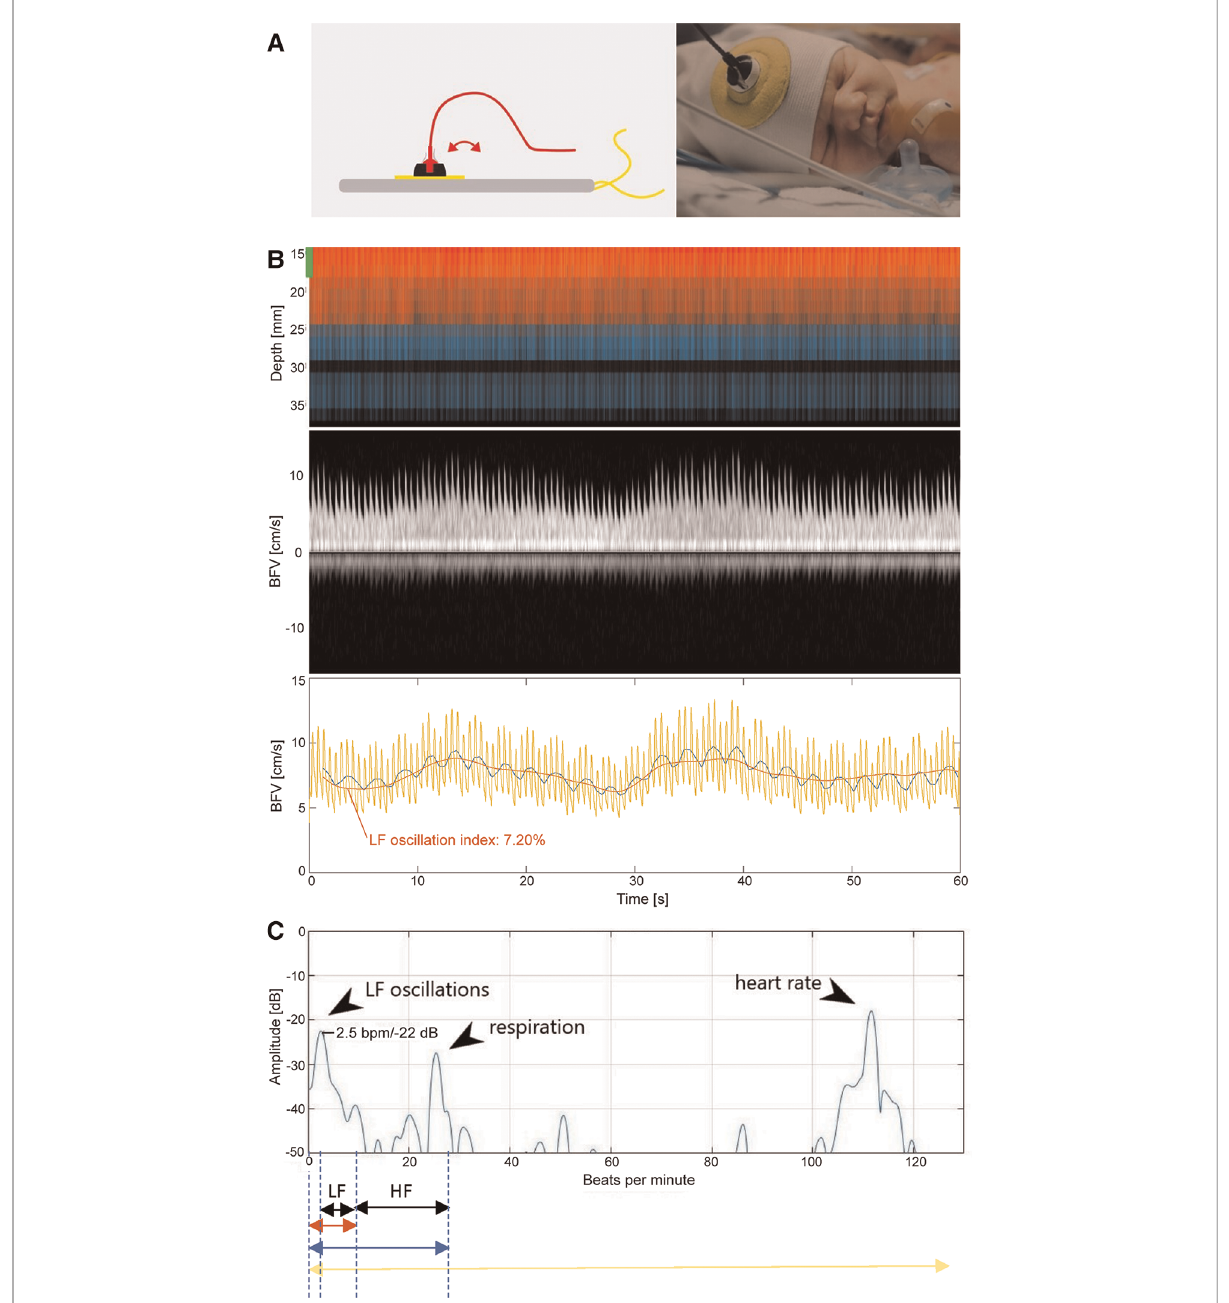
FIGURE 1 Low frequency oscillations recorded with NeoDoppler. ( A ) The soft elastic hat placed on the neonate ’ s head is shown in the picture on the right. The probe holder (yellow more robust fabric with a white plastic cup) and ultrasound probe (in black) is placed over the anterior fontanelle. The left picture shows how the ultrasound probe can be adjusted in the probe holder (shifted slightly horizontally, vertically or in a different angle) to optimize the Doppler signal. ( B ) Upper panel: Demonstrates the NeoDoppler M-mode of cerebral blood fl ow in different depths, with time of recording along the x -axis and depth of recording along the y -axis (60 s on all images). ( B ) Middle panel: Shows the Doppler spectrum for the chosen sample volume (5 mm). The low frequency oscillations (LFO) are the slow changes in blood fl ow velocity (2.5 cycles/min) that can be seen visually. ( B ) Lower panel: The Doppler velocity curve (yellow) derived from the Doppler spectrum in the ( B ) upper panel, with the same time scale. The y -axis represents velocity (cm/second). The blue curve is the sum of the Doppler velocity mean value, low frequency- and high frequency oscillations. The red curve is the sum of the mean value and LFO. The LFO index (here 7.2 percent), is the standard deviation in percent of the mean blood velocity value over the full one-minute recording. ( C ) The frequency spectrum of the Doppler velocity curve, is another way to illustrate the variations in the cerebral blood fl ow. The beats/min are seen along the x -axis and amplitude (decibel) along the y - axis. The fi rst peak at 2.5 beats/min, corresponding to 0.04 Hz (2.5/60 s), represents LFO. This slow periodic cycling is superimposed on the rhythm of other physiological parameters such as respiration (the second peak around 25 beats/min) and heart rate (peak around 115 beats/min). These three main periodic waves in the frequency spectrum correspond to the three curves in ( C ), as demonstrated with the red (LFO) blue (respiration) and yellow (heart rate) arrows below the frequency